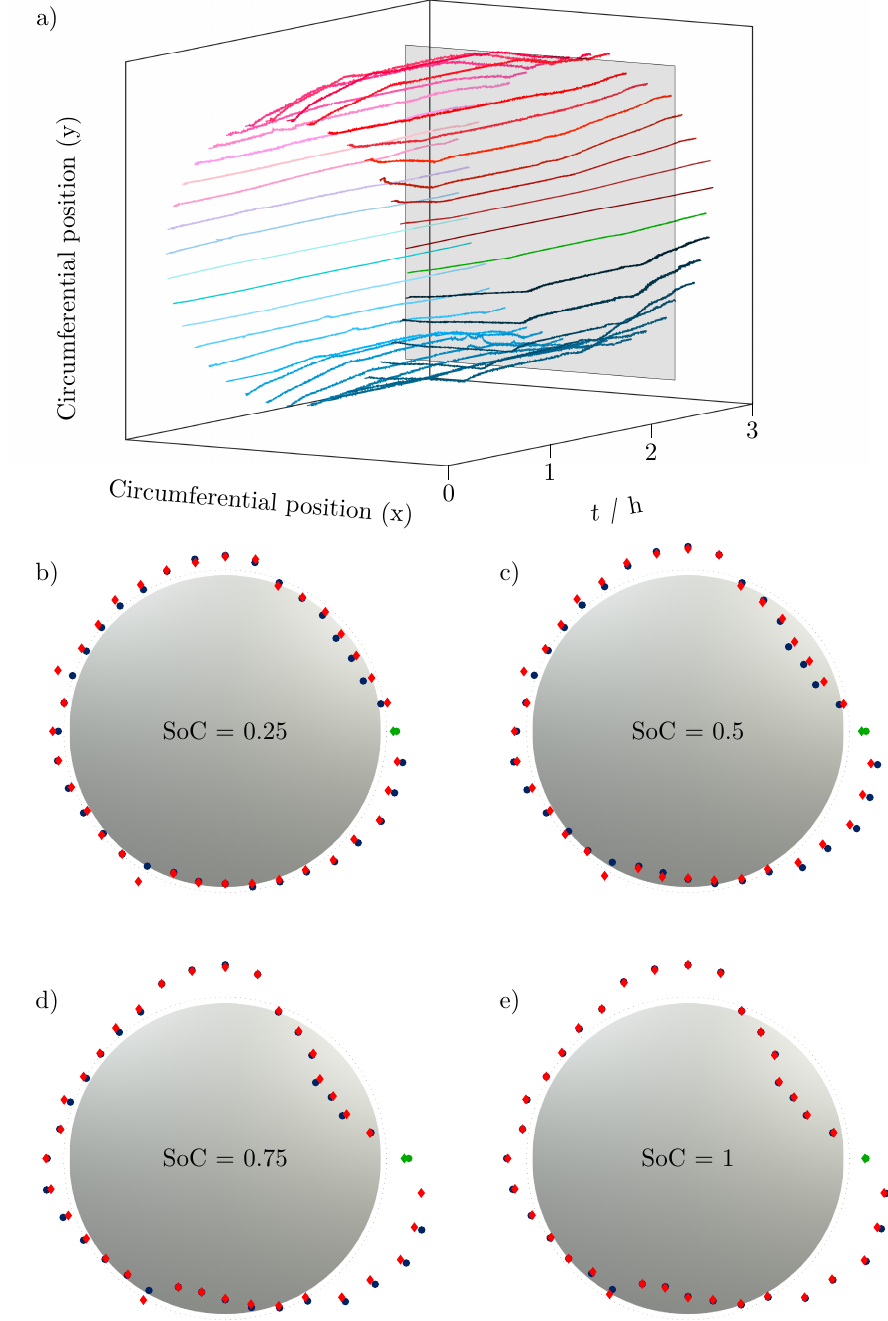
The change in radius at the position of the negative current collector tab is marked in green. The top view of the battery cell in gray reflects the initial shape of the cell.